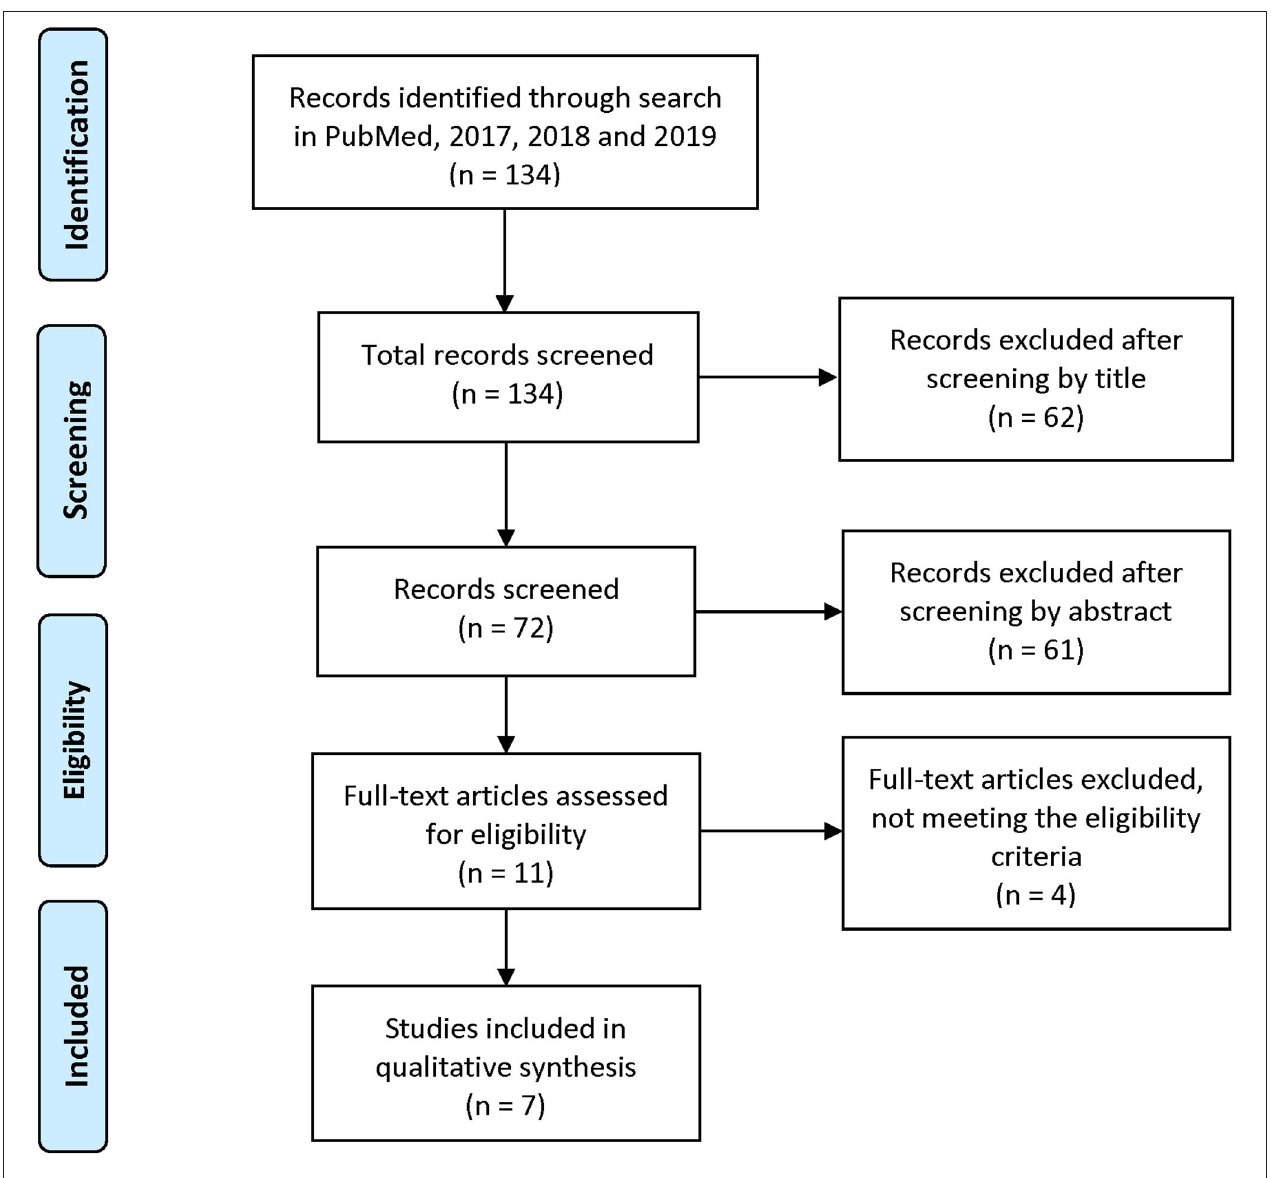
FIGURE 1 | PRISMA 2009 Flow Diagram. Adapted from Moher et al.